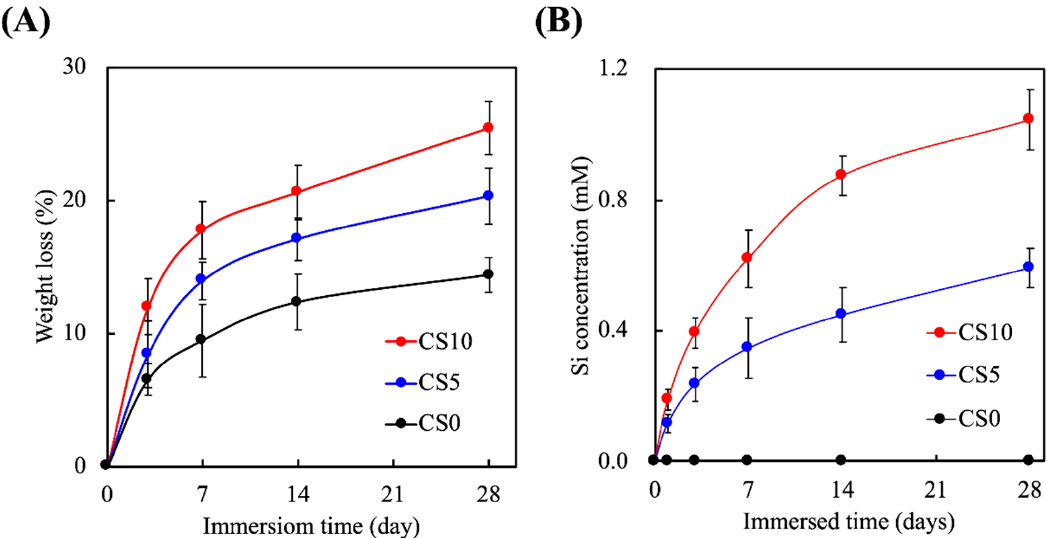
Figure 6. ( A ) Degradation rates and ( B ) release of Si ions of CS0, CS5 and CS10. Data presented as mean ± SEM, n = 6 for each group.